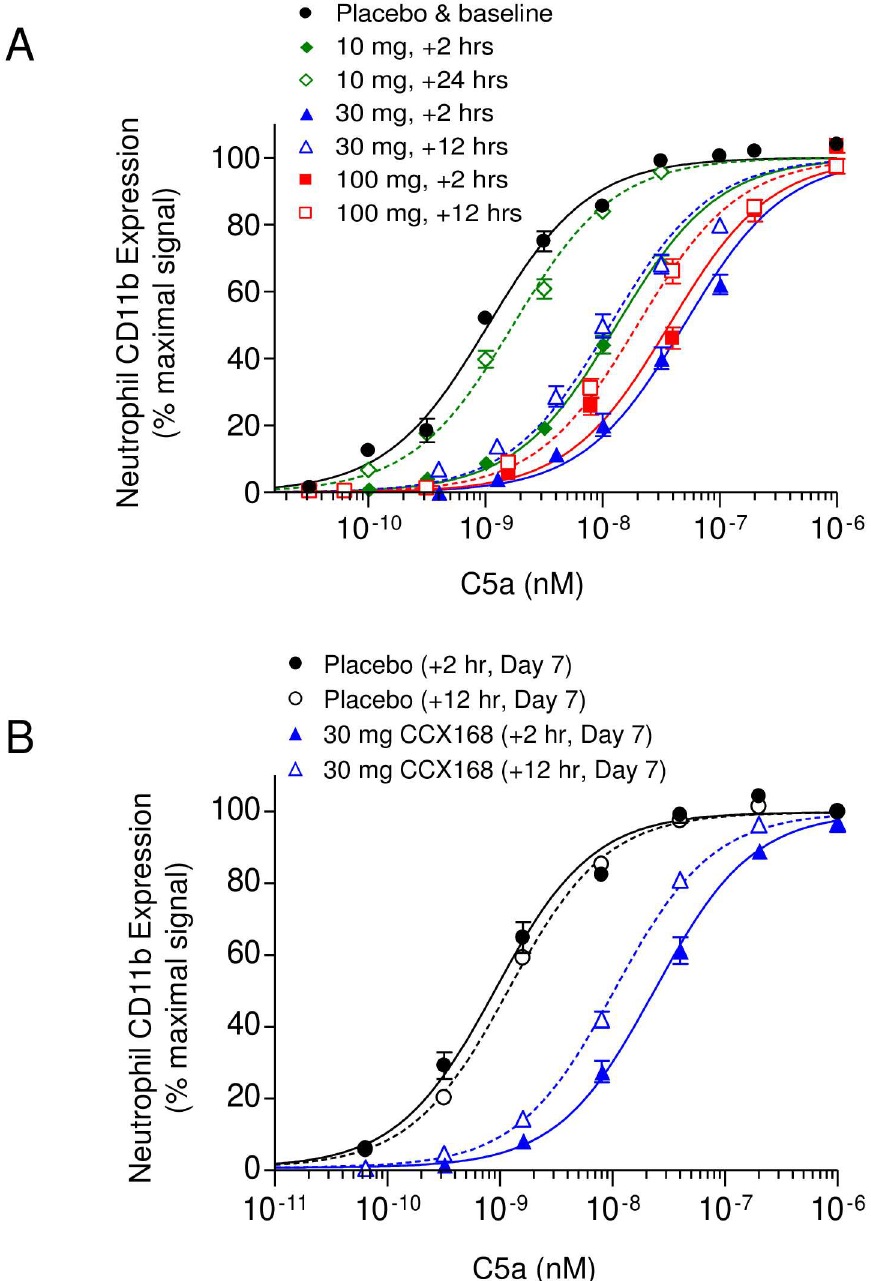
Fig 8. Pharmacodynamic Profile of CCX168 in Healthy Human Volunteers. Pharmacologic inhibitionof C5aR by CCX168 as measured with an on-site, whole-blood ex vivo assay of C5a activity. (A) C5a-induced upregulation of CD11b on the surface of neutrophils in whole blood collected in the placebo group ( ● ), and at 2 hours ( ♦ ) and 24 hours ( ^ ) after a single dose of 10 mg CCX168, at 2 hours ( ▲ ) and 12 hours ( Δ ) after a single dose of 30 mg CCX168, and 2 hours ( ■ ) and 12 hours ( □ ) after a single dose of 100 mg CCX168. CD11b upregulation was diminishedin blood from subjects dosed with CCX168. (B) C5a-induced upregulation of CD11b on the surface of neutrophils in whole blood collected at 2 hours ( ● ) or 12 hours ( (cid:14) ) after the last dose of a 7-day regimen of placebo, or 2 hours ( ▲ ) or 12 hours ( Δ ) after the last dose of a 7-day regimenof 30 mg CCX168 given twice daily. CD11b upregulation was diminished in both blood samples from CCX168 subjects with a 10-fold decrease in C5a potency exhibited in the 12-hour